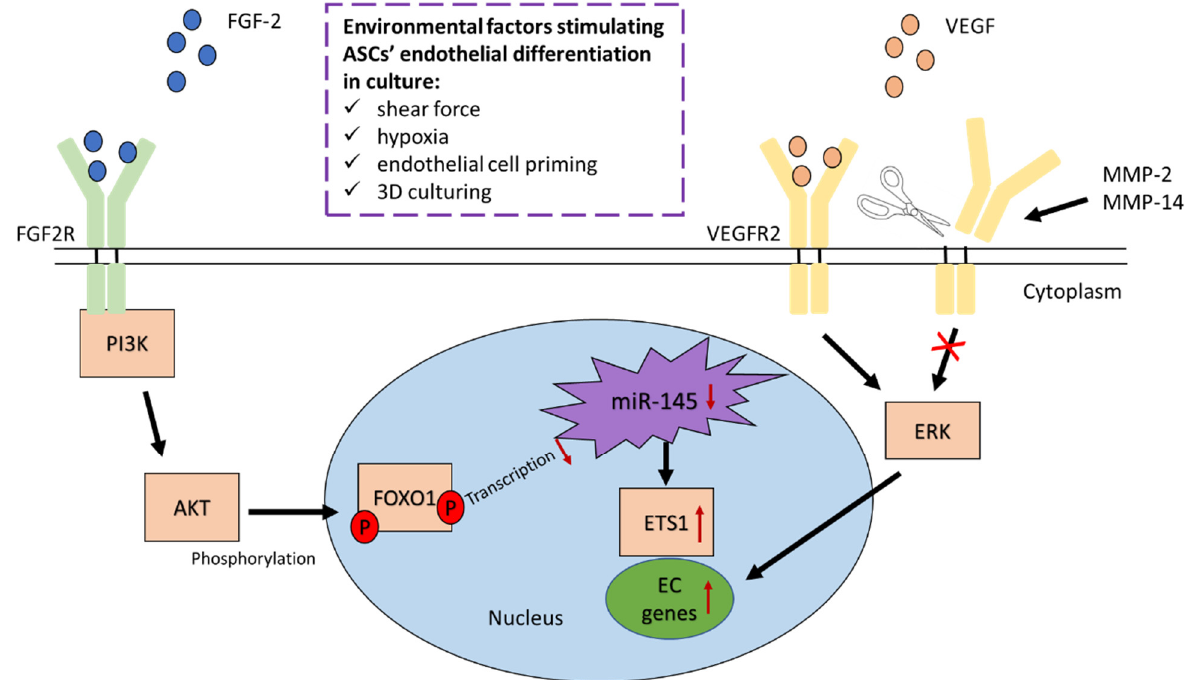
Figure 2. Major factors affecting adipose-derived mesenchymal stem/stromal cell (ASC) differentiation into endothelial cells (ECs). Fibroblast growth factor 2 (FGF-2) activates the phosphoinositide 3-kinase (PI3K)/protein kinase B (AKT) pathway, leading to the phosphorylation of forkhead box protein O1 (FOXO1), which decreases its transcriptional activity. As a result, the levels of miR-145 decrease and the levels of its downstream target V-ets avian erythroblastosis virus E26 oncogene homolog 1 (ETS1) increase, which upregulate the transcription of EC-related genes. VEGF, on the other hand, activates ERK signaling pathway via VEGFR2 activation, leading to upregulation of EC genes, while MMP2 and -14 induce VEGFR2 cleavage and decrease in downstream signaling. Additionally, environmental factors such as shear force, hypoxia, EC priming of ASCs and 3D culture conditions enhance endothelial differentiation of ASCs.